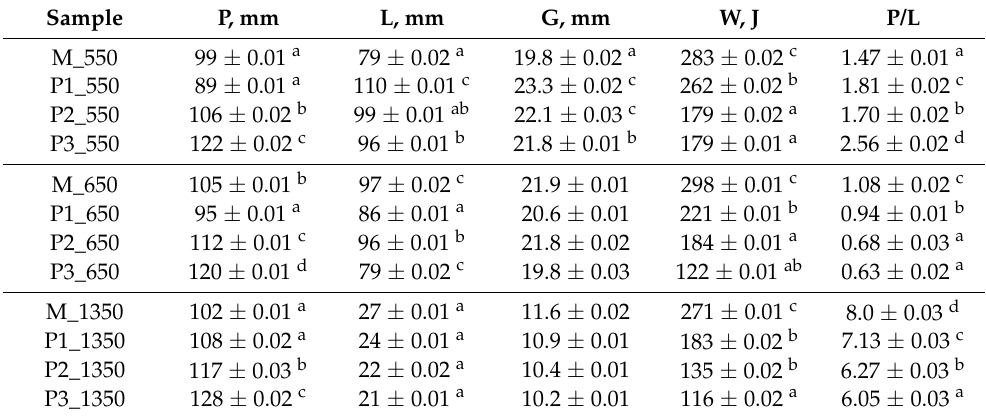
Figure 3. ( a ) G ′ G ″ dough modulus (points) and power curves (lines) depending on temperature at 550 flour dough samples for four different amounts of added oil: 0% (red point), 5% (green point), 10% (blue point), and 15% (purple point); ( b ) G ′ G ″ dough modulus (triangle with tip up) and power curves (lines) depending on temperature at 650 flour dough samples for four different amounts of added oil: 0% (red triangle), 5% (green triangle), 10% (blue triangle), and 15% (purple triangle); ( c ) G ′ G ″ dough modulus (triangle with tip up) and power curves (lines) depending on temperature at 1350 flour dough samples for four different amounts of added oil: 0% (red triangle), 5% (green triangle), 10% (blue triangle), and 15% (purple triangle). Table 1. Results of alveographer characteristics for wheat flour with the addition of hemp seed oil.